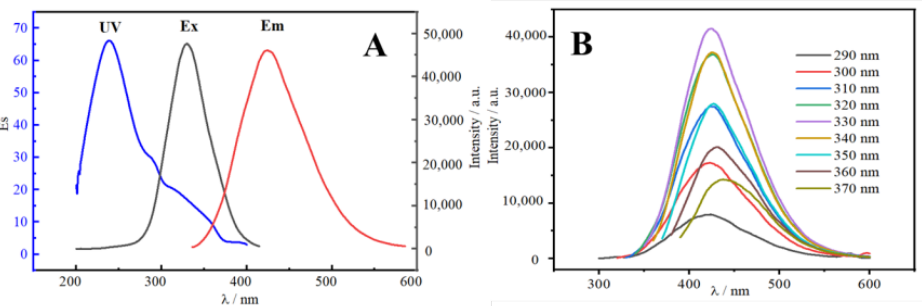
Figure 4. ( A ) UV/Vis absorption (UV), excitation (E x ), and emission (E m ) spectra of N-CDs. ( B ) Emission spectra at various wavelengths of excitation (290 – 370 nm).